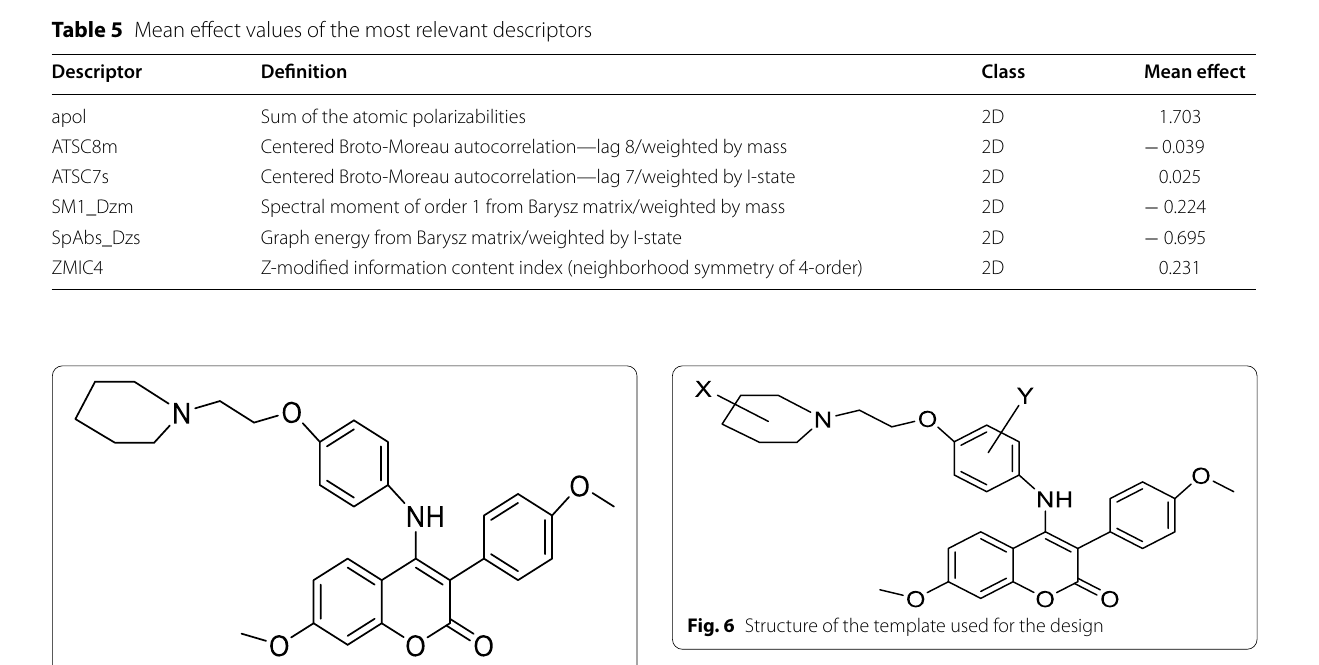
Fig. 5 Structure of the reference compound